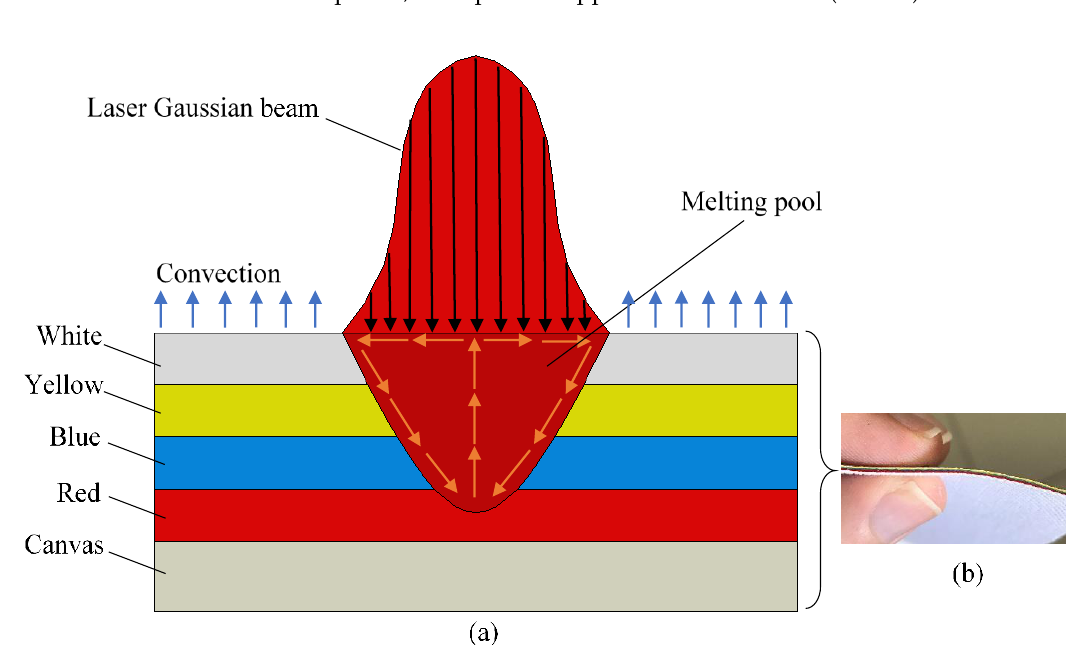
Figure 8. ( a ) Schematic of laser melting and the heat transfer in the molten pool. ( b ) The applied layers of paints on top of the canvas.